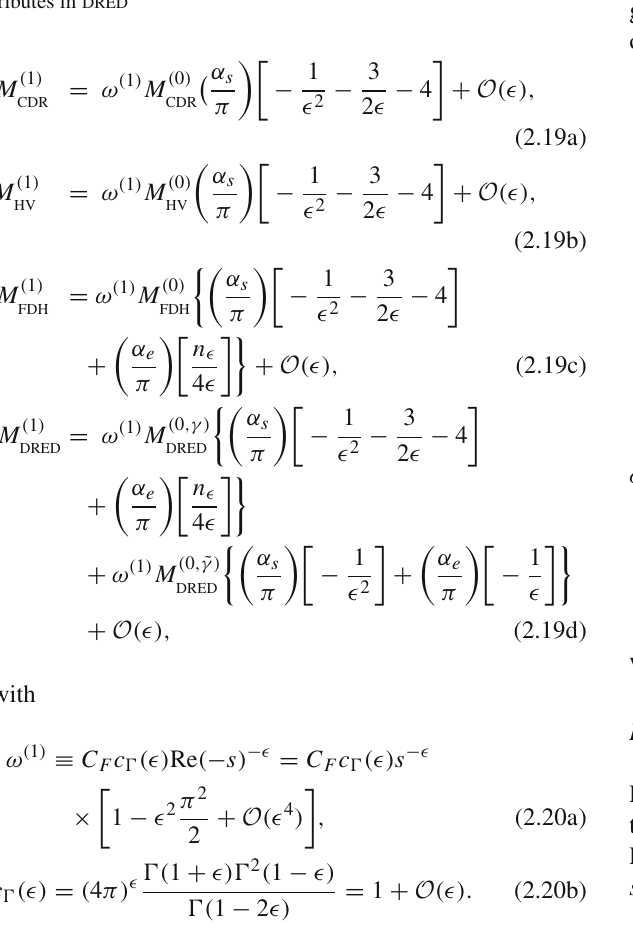
Fig. 4 Counterterm diagram for e + e − → γ ∗ → q ¯ q which only con- tributes in dred